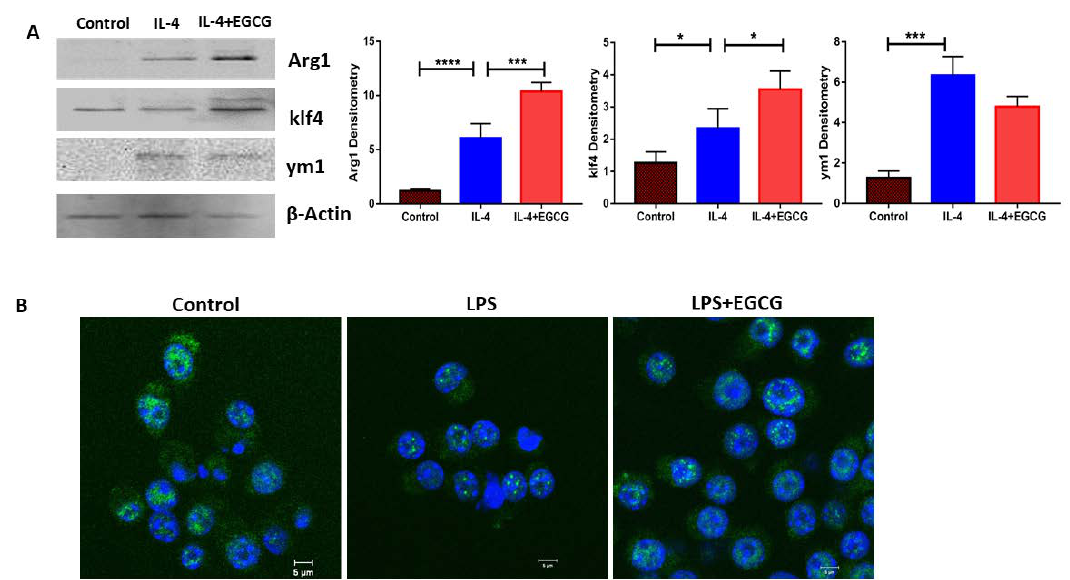
Figure 4. E ff ects of EGCG on IL-4-induced M2 polarisation. ( A ) RAW cells were stimulated with IL-4 in the presence or absence of EGCG for 24 h and M2 markers were analysed. Immunoblots of Arg1, KLF4 and ym1 demonstrated enhanced expression of these proteins by EGCG in macrophages. ( B ) KLF4 immunofluorescence was demonstrated LPS-induced downregulation, which was enhanced after EGCG incorporation ( n = 3 or more). Significant di ff erence * p < 0.05, *** p < 0.001 and **** p < 0.0001.